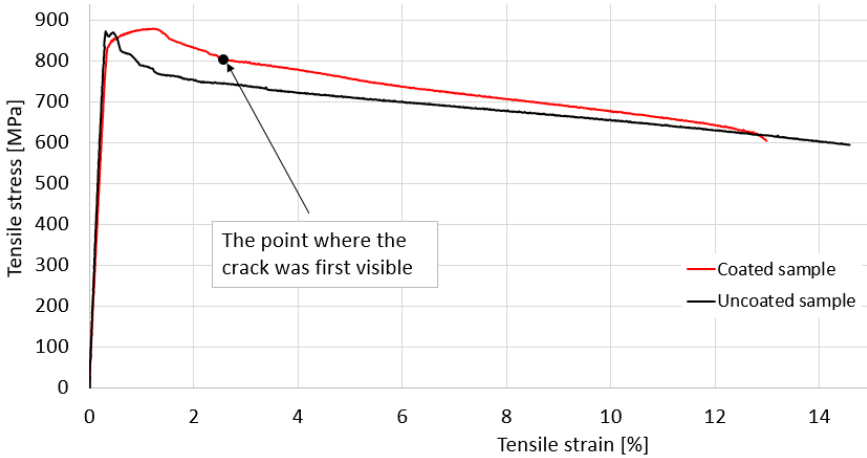
Figure 3. Sample A — static tensile test. ( a ) View of the sample during the tensile test. ( b ) Sample broken in static tensile test. ( c ) Front views of the fracture surfaces of the tensile specimen.